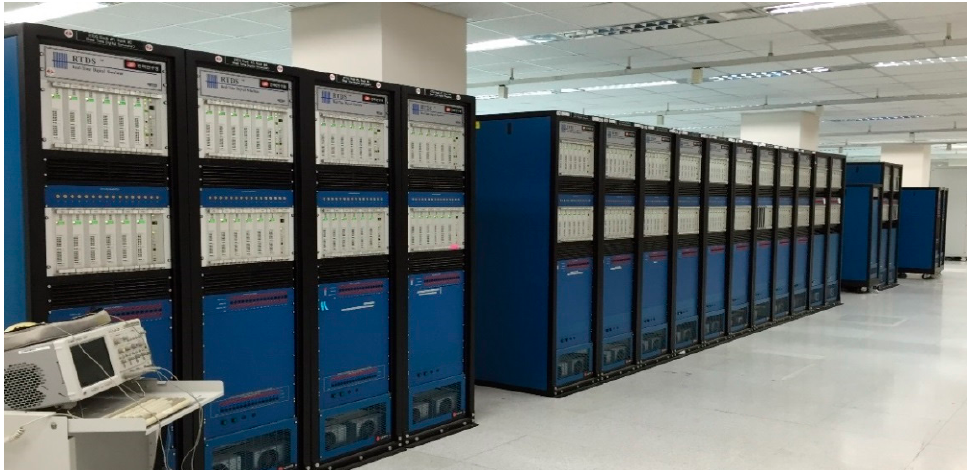
Figure 3. Real-time Digital Simulator in the Korea Electric Power Corporation (KEPCO) Research Institute.